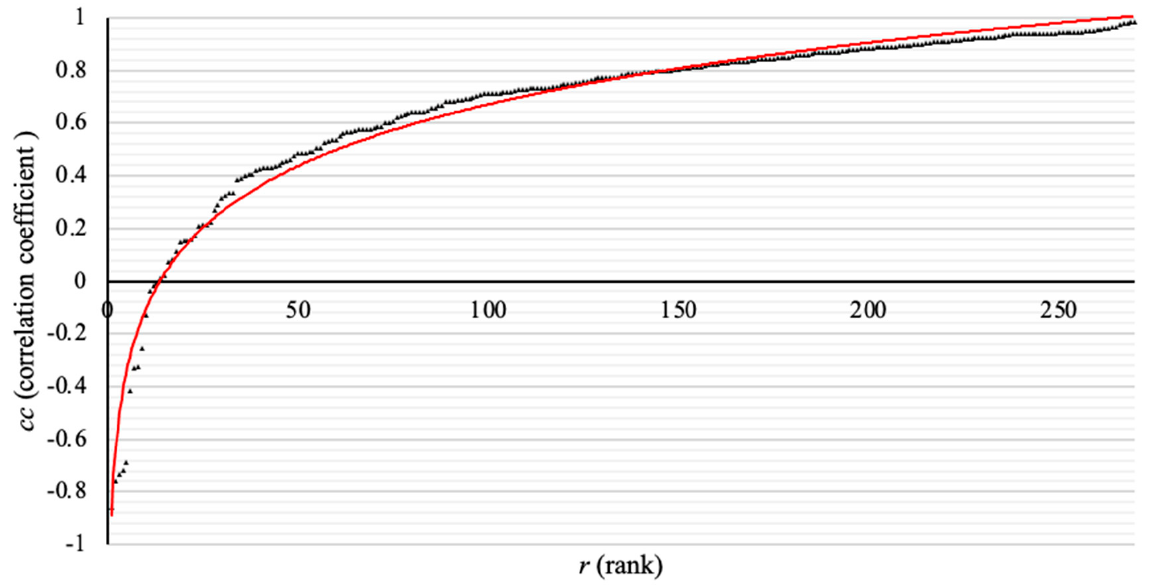
Figure 6. The correlation coefficient of the AESI and GDP on the fitting curve in ascending order.